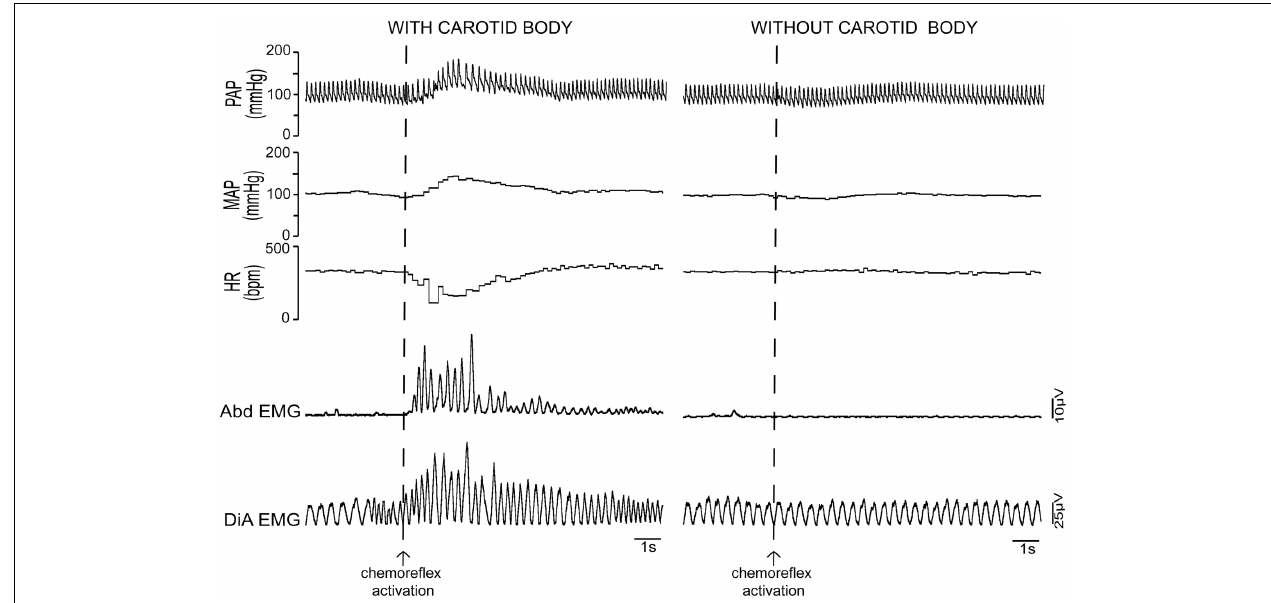
FIGURE 3 | Cardiovascular and respiratory responses to peripheral chemoreflex activation: importance of the carotid body. Activation of the peripheral chemoreflex with environmental hypoxia in intact unanesthetized rats produces a marked increase in pulsatile (PAP) and mean arterial pressure (MAP), a decrease in heart rate (HR) and hyperventilation with forced inspiration and expiration, as can be seen by